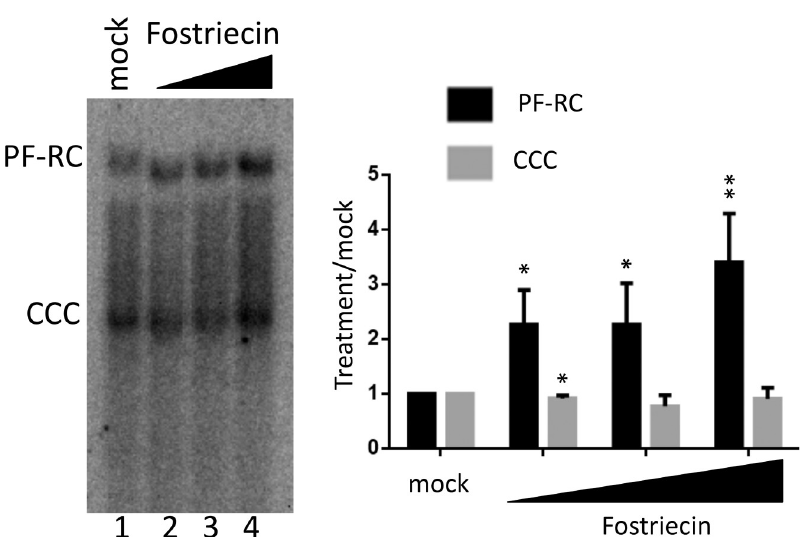
Fig 12. Effect of PP2A inhibition on HBV infection. HepG2-NTCP cells were infected with HBV for one day. Following removal of the inoculum, the cells were mock treated or treated with the PP2A inhibitor Fostriecin (20 μ M, 40 μ M, 80 μ M). HBV PF DNA was extracted three days post-infection and detection by Southern blot analysis. PF-RC, PF-RC DNA; CCC, CCC DNA. In the graph, PF-RC DNA and CCC DNA signals from Fostriecin-treated cells were compared to mock treatment, which was set to 1.00. � , P < 0.05; �� , P <